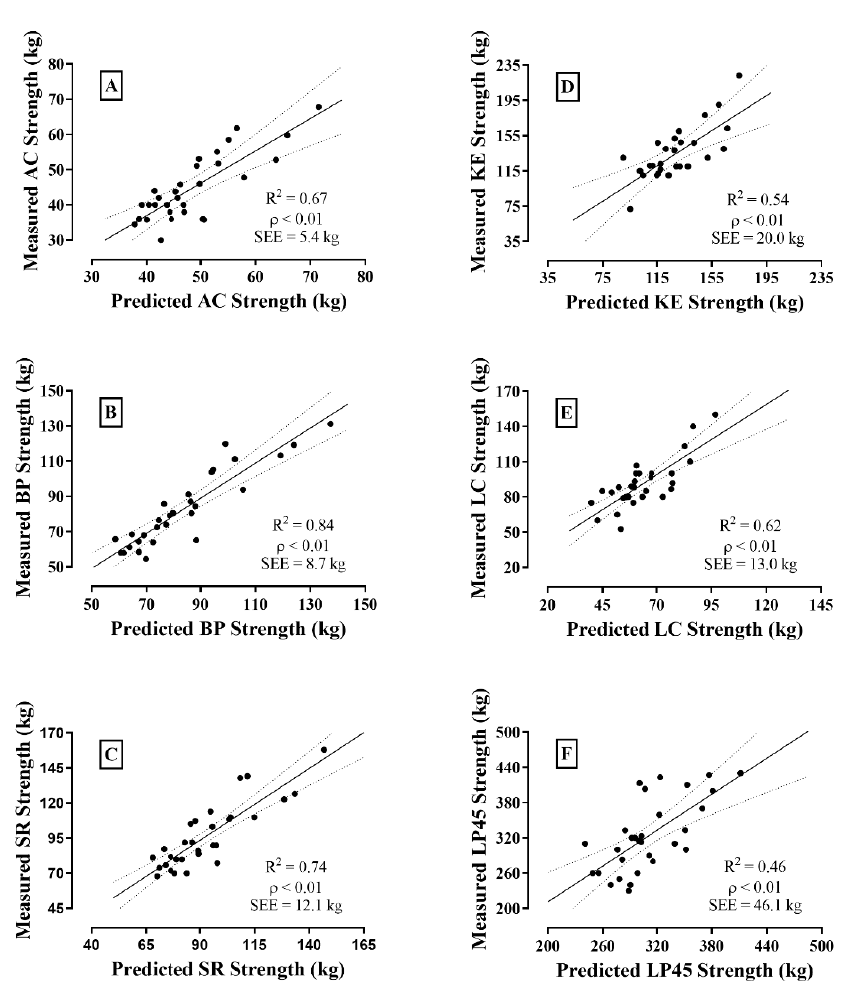
Figure 1. Scatterplots between observed and predicted values for the 1RM tests in bench press (BP) ( A ); arm curl (AC) ( B ); seated row (SR) ( C ); knee extension (KE) ( D ); leg curl (LC) ( E ); and leg press 45° (LP45) ( F ).